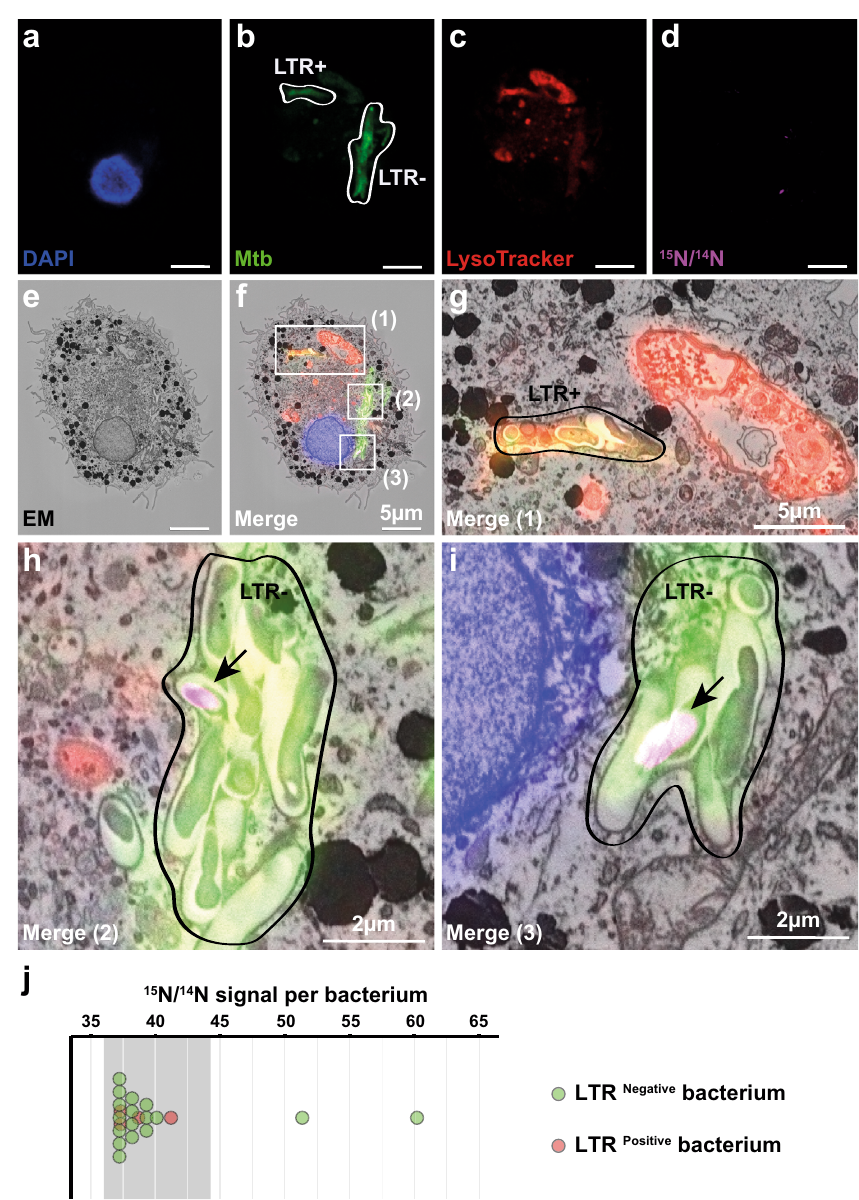
Fig. 4 CLEIM reveals that PZA/POA is able to accumulate within Mtb residing in non-acidic compartments. a – i Mtb-infected MDM were treated with 30mg/L [ 15 N 2 , 13 C 2 ]-PZA for 24h. The sample was then stained with 200nM LysoTracker before chemical fi xation and counter-stained with DAPI. After confocal fl uorescence imaging, sample was embedded and the cell of interest was processed for correlative electron and ion microscopy. Representative fl uorescence images corresponding to ( a ) nuclear staining (blue), ( b ) Mtb WT (green), ( c ) LysoTracker (red) were overlaid with ( d ) the 15 N/ 14 N signal (purple) and ( e ) the EM micrograph (black and white). Merging of the fi ve channels is shown in ( f ) where three regions of interest numbered (1), (2) and (3), respectively, are highlighted by white rectangles. Scale bars correspond to 5 µ m. Micrographs are representative of one single experiment. g Magni fi cation of region (1) shows bacteria contain within LTR positive compartment devoid of any detectable PZA/POA. Scale bar corresponds to 5 µ m. h , i Magni fi cations of regions (2) and (3) highlight PZA/POA accumulation in LTR negative microenvironment. Scale bar corresponds to 2 µ m. j Quanti fi cation of 15 N/ 14 N signals associated with each bacterium contained in LysoTracker positive and negative microenvironments. LysoTracker positivity was determined by measuring the mean fl uorescence values from the two compartments of interest. Diffuse signal from the cytosol was estimated between 10 and 20AU and considered as background, whereas mean values were 22.6 and 60.4AU for negative and positive compartments respectively. Grey line indicates 15 N/ 14 N natural background level. Bacterium with strong positive 15 N/ 14 N signals correspond to the bacterium highlighted in (2) and (3) respectively. Source data are provided as Source Data fi